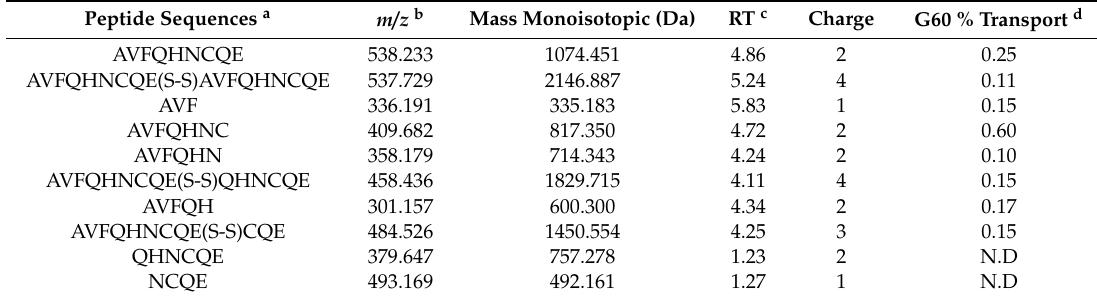
Table 3. Transport of peptide and fragments from G60 through Caco-2